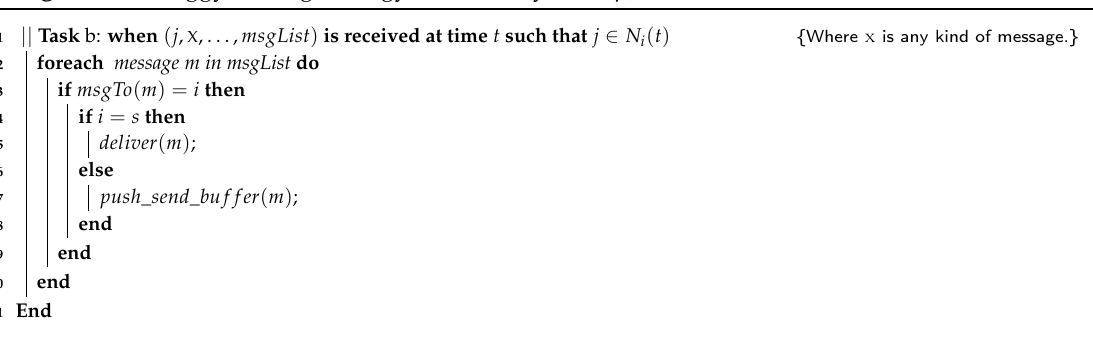
Algorithm 5: Piggybacking strategy executed by node p i